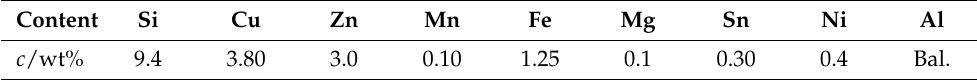
Table 1. Chemical composition of the A380 bulk alloy in